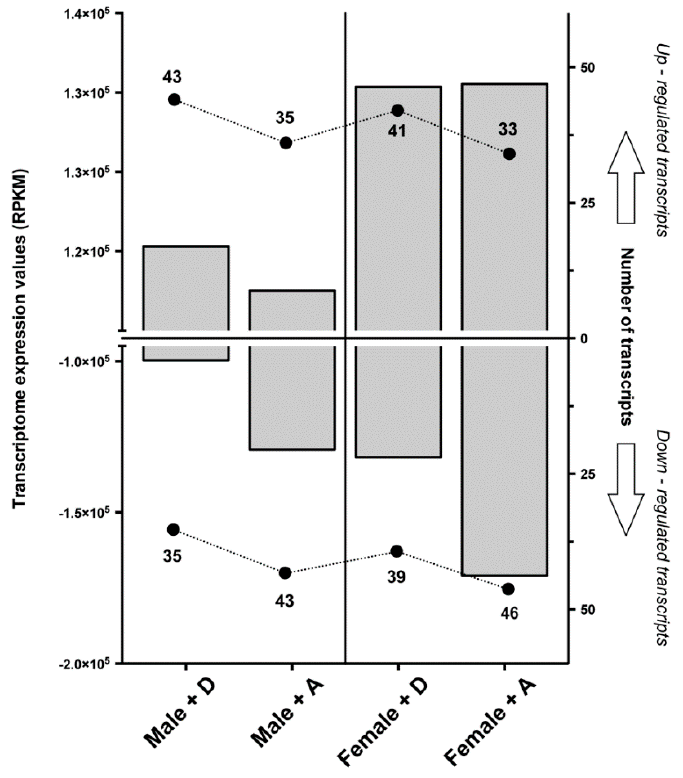
Figure 1. Total transcriptomic response of the glutamatergic synapse pathway in male and female Caligus rogercresseyi exposed to xenobiotic drugs. In the left Y -axis (gray bars), the sum of expression values for up- and down-regulated transcripts after drug exposure are shown. Values correspond to differences in Reads Per Kilobase of transcript per Million mapped reads (RPKM) values as compared to the same transcripts in the control condition. In the right Y -axis (plot points), the total number of up- and down-regulated transcripts after drug application are shown. +D: Deltamethrin, +A: Azamethiphos.